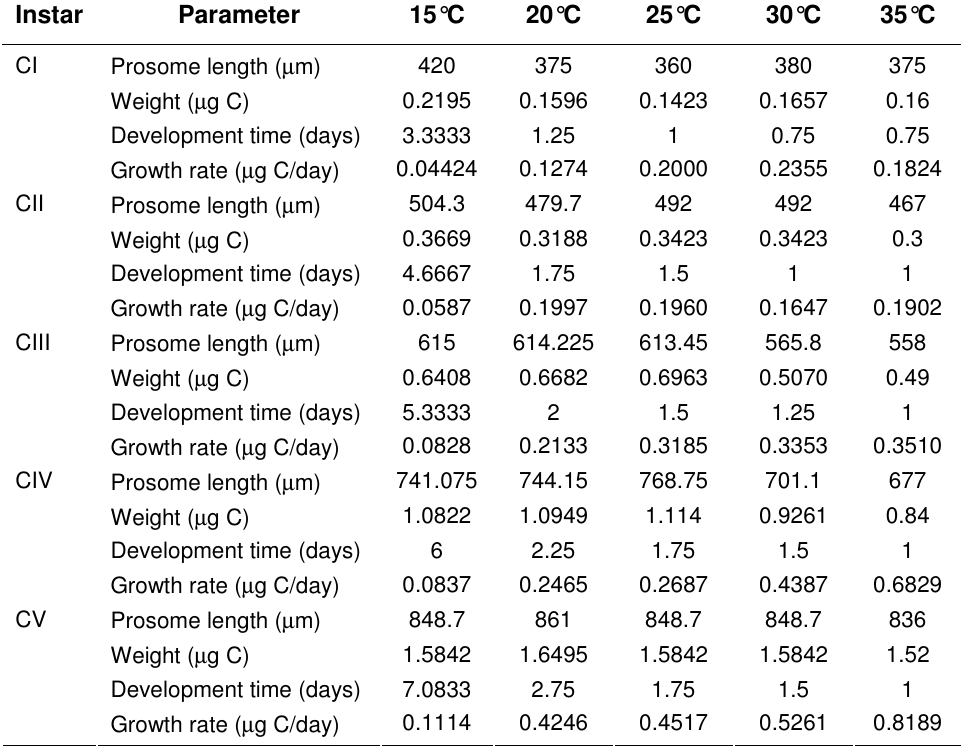
Effects of Temperature on Development and Growth of Copepodite Stage of P. dubia